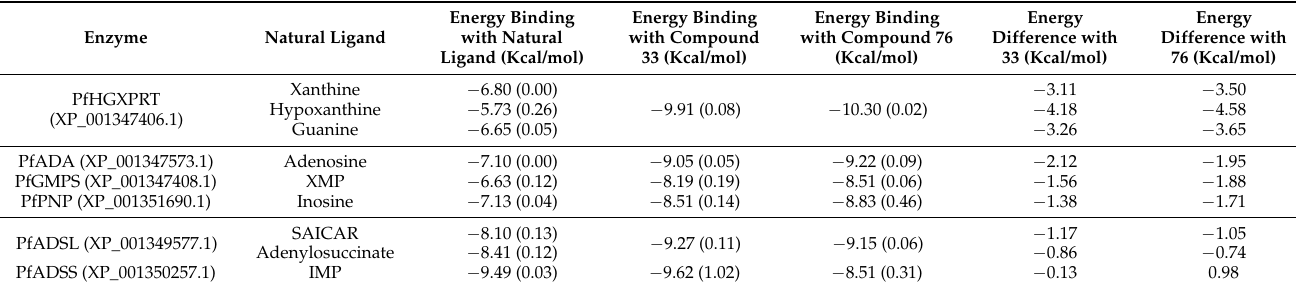
Table 3. Free binding energies of molecular docking between natural ligands and hit compounds with enzymes from the purine salvage pathway of P. falciparum 3D7.